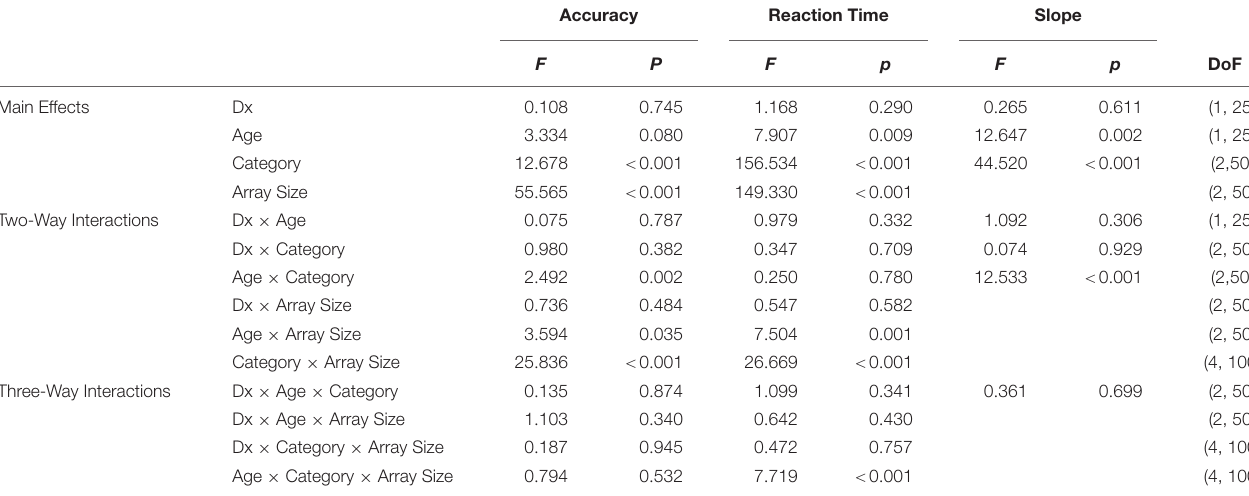
TABLE 2A | Category task statistics.